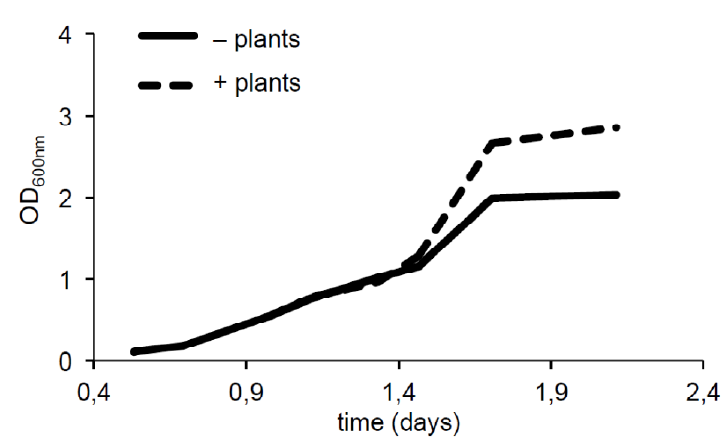
Figure S4. Growth of S. meliloti in the presence of Arabidopsis plants. Proliferation of S. melioti measured over the period of 2 days in medium with or without Arabidopsis